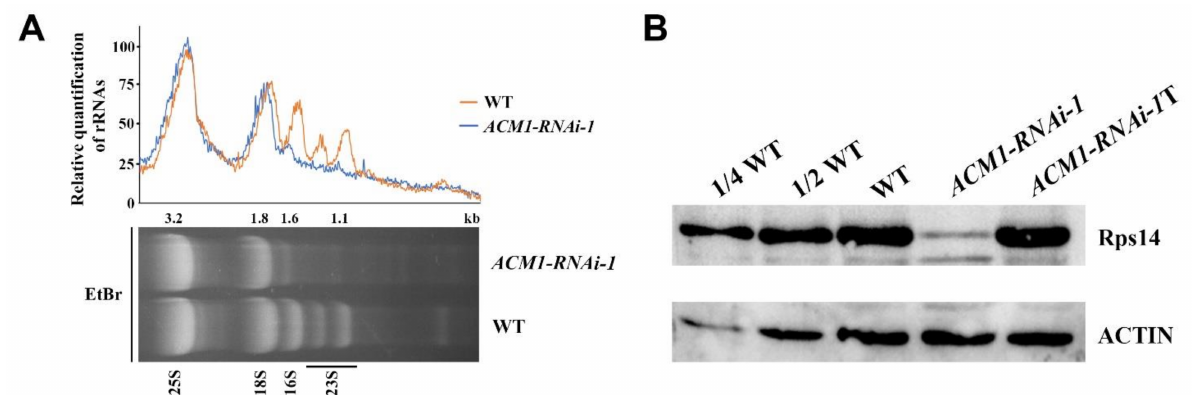
Figure 8. The abundance of rRNA and accumulation of ribosomal subunit RPS14. ( A ) Five µ g of total RNA from 7-day-old WT and ACM1 -RNAi-1 seedlings was separated on a denaturing gel. rRNA was quantified using ImageJ software. The value of cytoplasmic 25S rRNA in ACM1 -RNAi-1 was set to 100, and the relative values of other RNAs were obtained by comparing with 25S rRNA. ( B ) Immunoblot of chloroplast ribosomal subunits Rps14 in the 7-day-old cotyledon of WT and ACM1 -RNAi-1 seedlings and 14-day-old true leaves in ACM1 -RNAi-1 line. ACTIN was considered a control. All experiments were repeated three times. T refers to the proteins in true leaves of ACM1 -RNAi-1